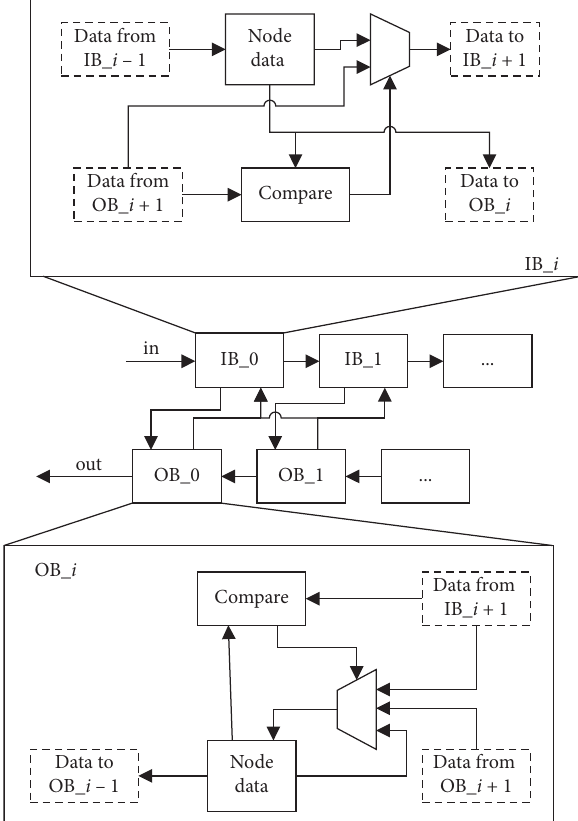
Figure 7: Detailed architecture of the OPEN list queue.